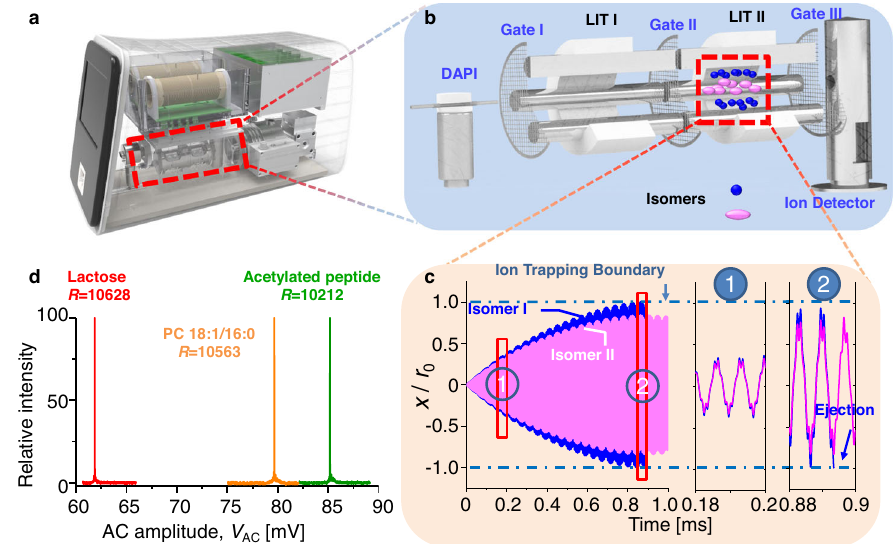
Fig.1|Instrumentalsetup,principal,andperformancecharacterizationofthe ioncloudpro fi lingtechnology. Schematicsof a theminiatureMSsystemusedin thisworkand b its key components for isomerstructural analysis. c Simulatedion trajectories for two isomeric ions characterized by reduced damping coef fi cients: b 0 =0.0010 (blue) and 0.0012 (purple). Here, b 0 =2 b = Ω m , where Ω is the angular frequence of the RF fi eld, m is ion mass, b is the damping coef fi cient of the ions. Insets, zoom-in plots of the ion trajectories at the beginning (1) and ejection (2) stages of the AC excitation. Isomeric ions are ejected sequentially according to their DCSs when their oscillation amplitudes exceed the trap geometry, r 0 , as